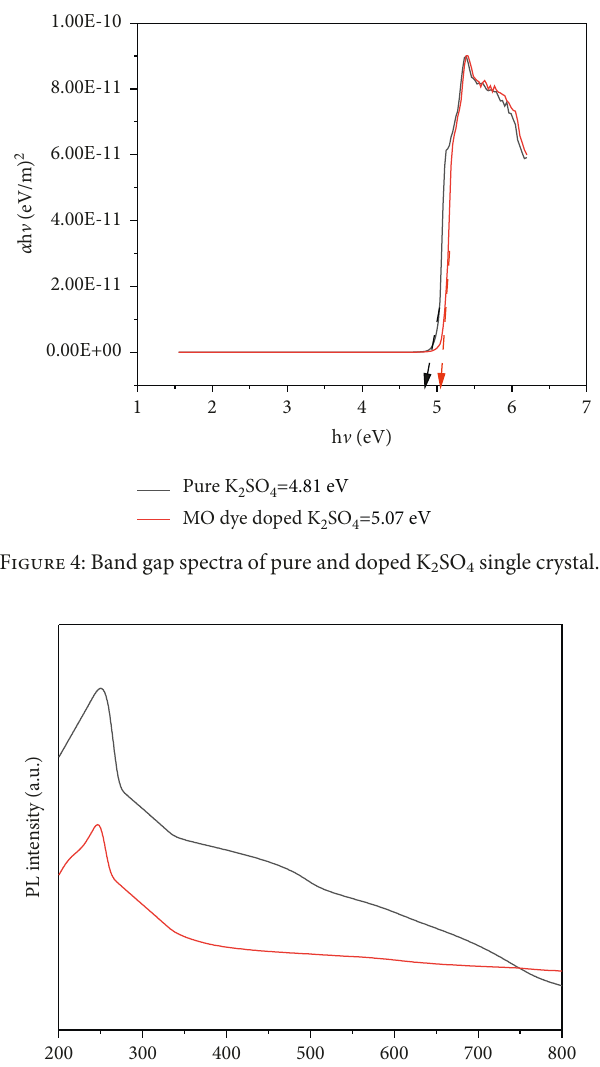
Figure 7: EDX spectra of the methyl orange dye-doped K single 2 SO 4